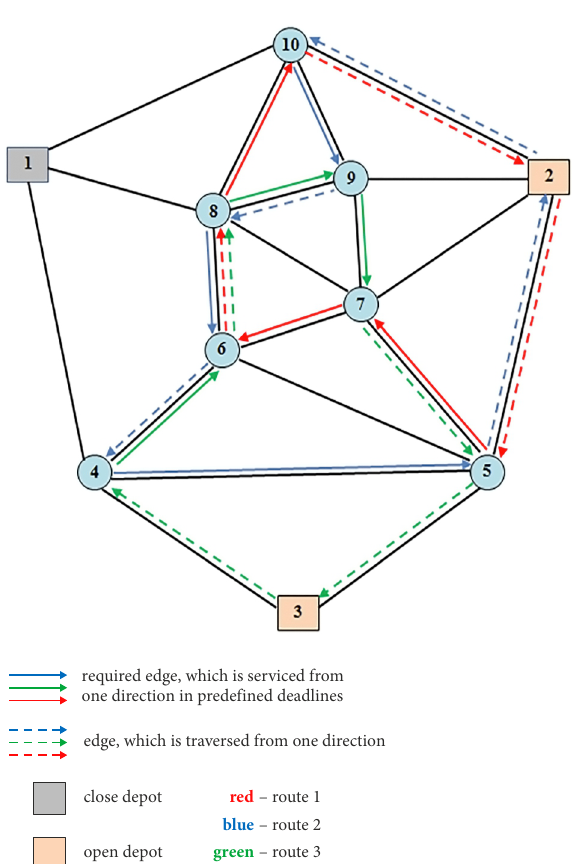
required edge, which is serviced from one direction in predefined deadlines edge, which is traversed from one direction close depot open Figure 1. A sample feasible solution for a CLARPD instance